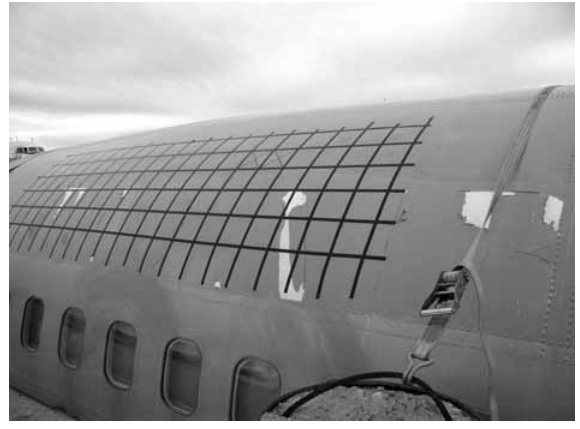
Fig. 16. Outside view of basic shield test set-up.